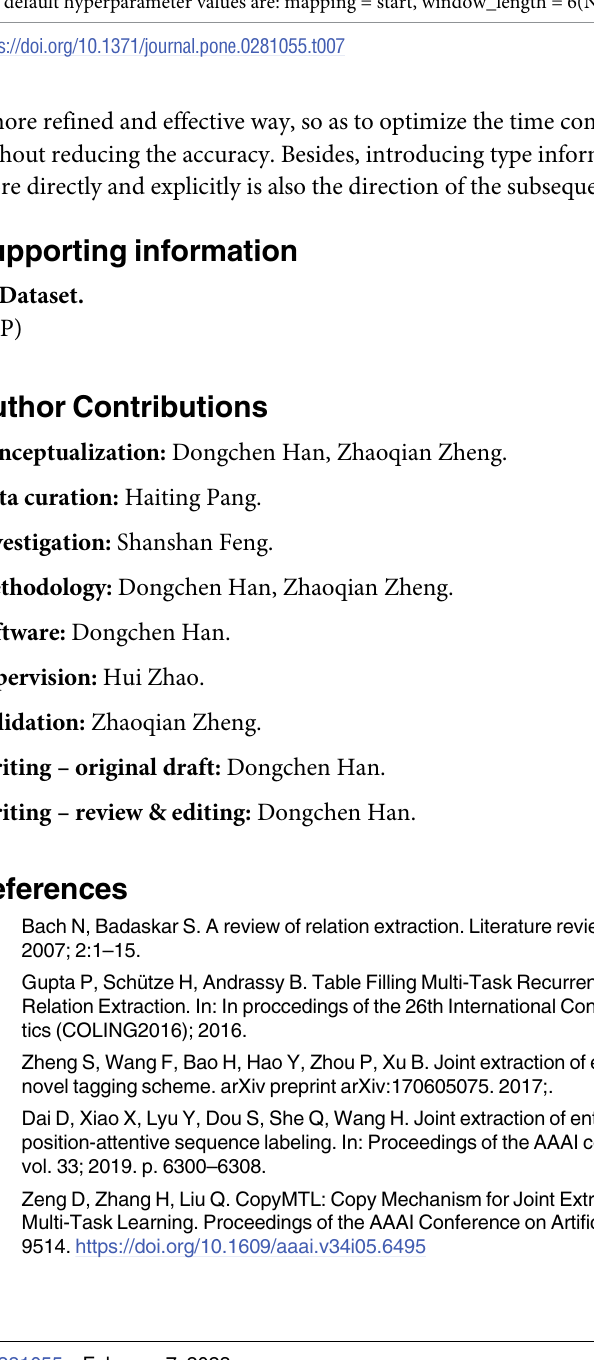
without reducing the accuracy. Besides, introducing type information and type constraints more directly and explicitly is also the direction of the subsequent research.